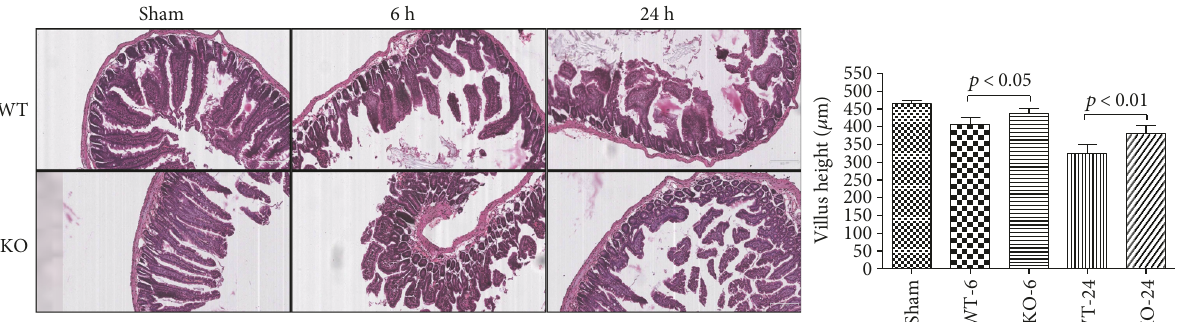
Figure 7: Lack of 5-HT alleviates the histopathology damage and organ dysfunction in the intestine in CLP-induced sepsis in mice. The intestine tissues were harvested at 6 h or 24 h after CLP administration. H&E staining was conducted as described above. In the intestine sections, the KO-CLP mice showed a reduced in fi ltration of in fl ammatory cells, edema in the space bounded by the villus, and separation of the epithelium from the basement membrane. The villus height was measured as an assessment of intestine dysfunction ( n = 6 , villus height: mean ± SD, p < 0 05 versus the WT-CLP group at 6 h after the CLP administration; p < 0 01 versus the WT-CLP group at 24 h after the CLP administration).